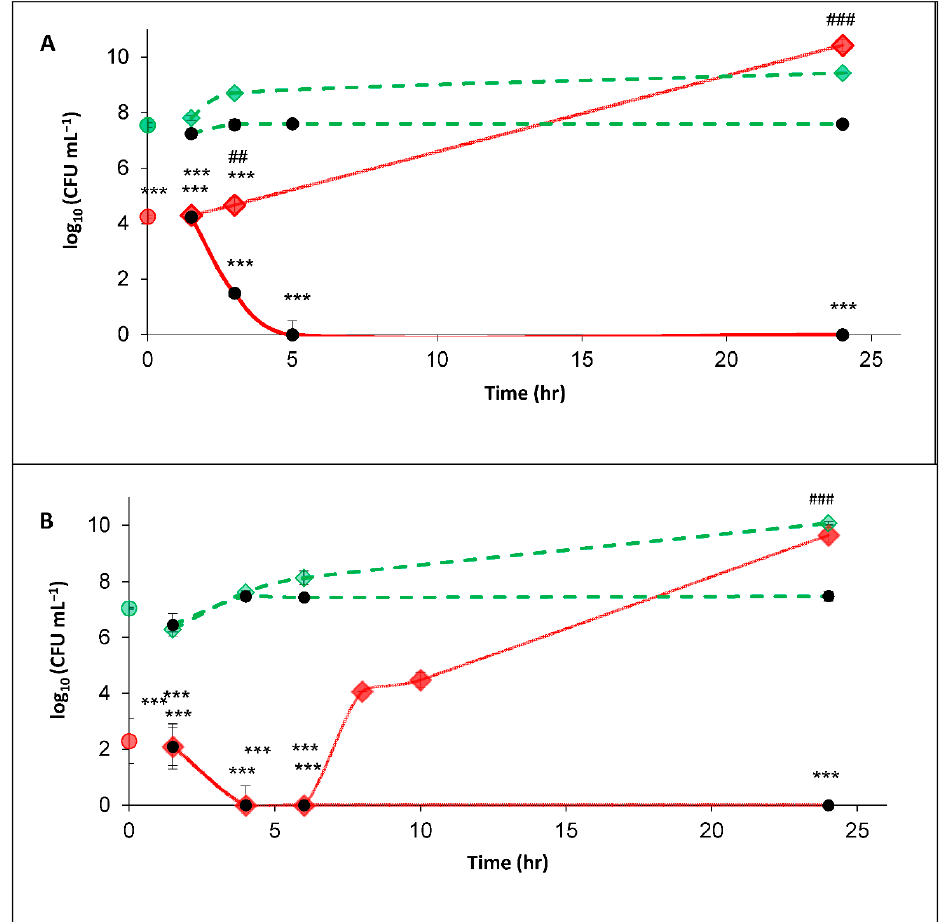
Figure 3. CFU mL − 1 of PEF-treated and nontreated S. aureus ( A ) and P. putida F1 ( B ). PEF-treated bacteria in time ‘0’ ( ); non-treated bacteria in time ‘0’